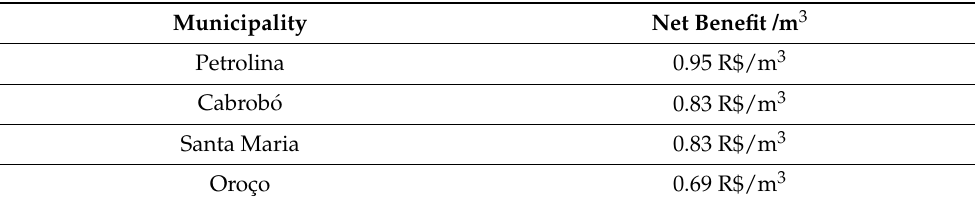
Table A2. Net benefits for agriculture (irrigation)